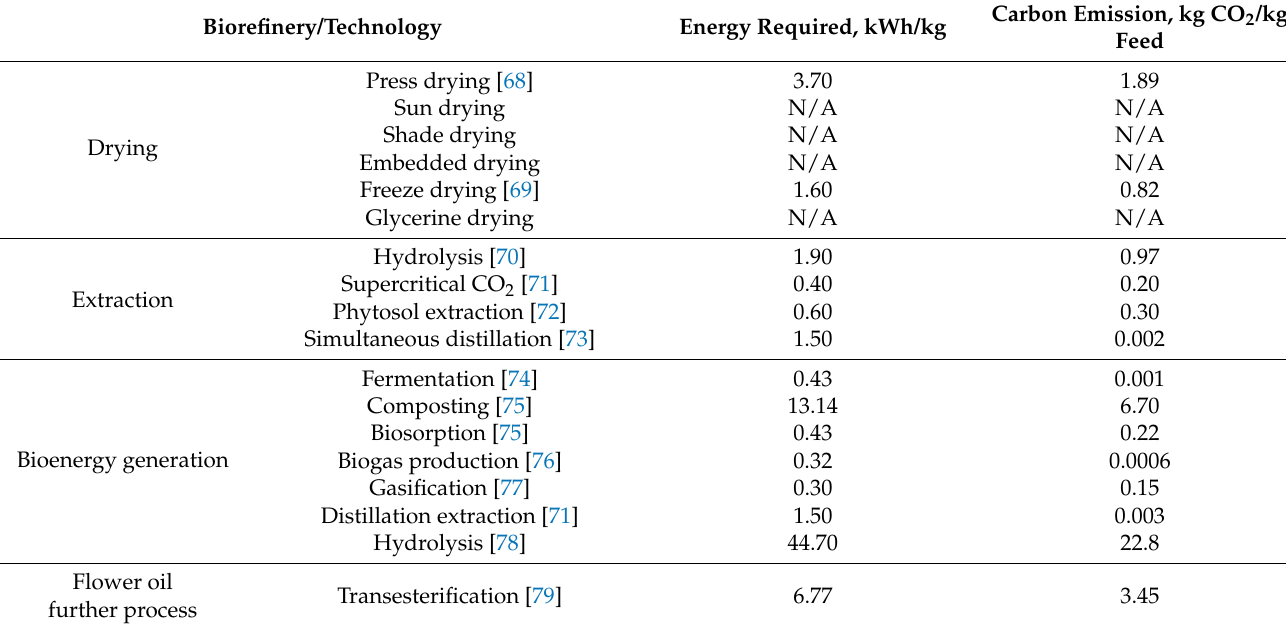
Table 9. Energy required, and carbon emission for different